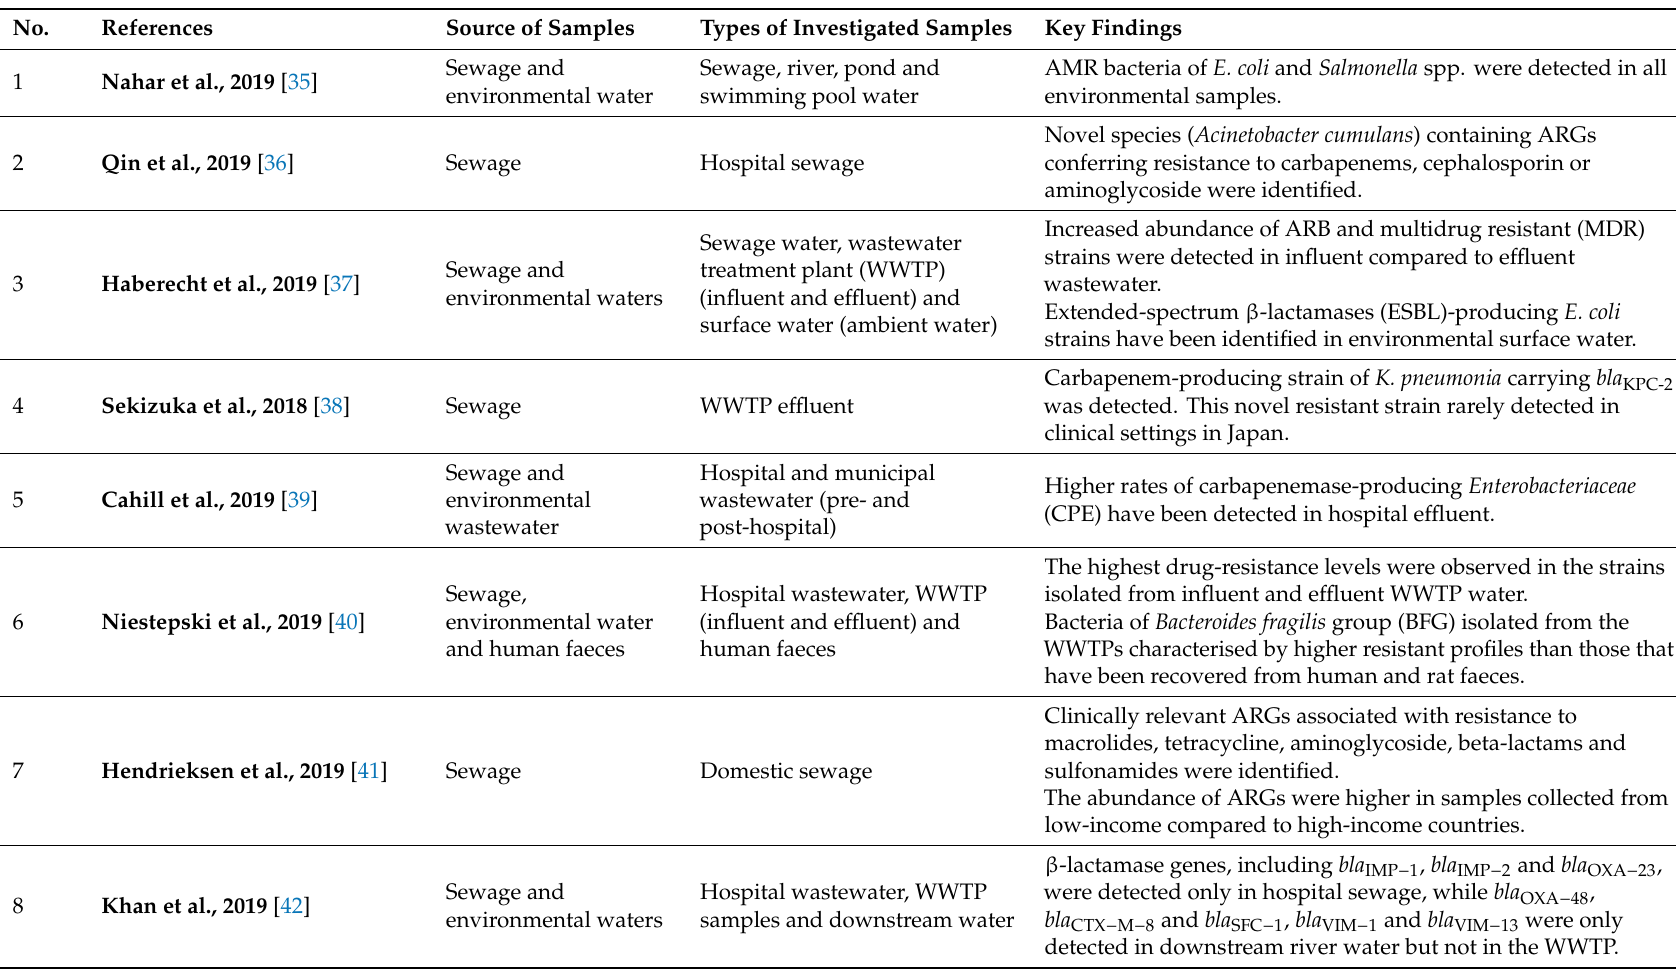
Table 1. Overview of the studies included in this systematic review. AMR: antimicrobial resistant, ARG: antimicrobial resistant genes, ARB: antimicrobial resistant bacteria and MGE: mobile genetic